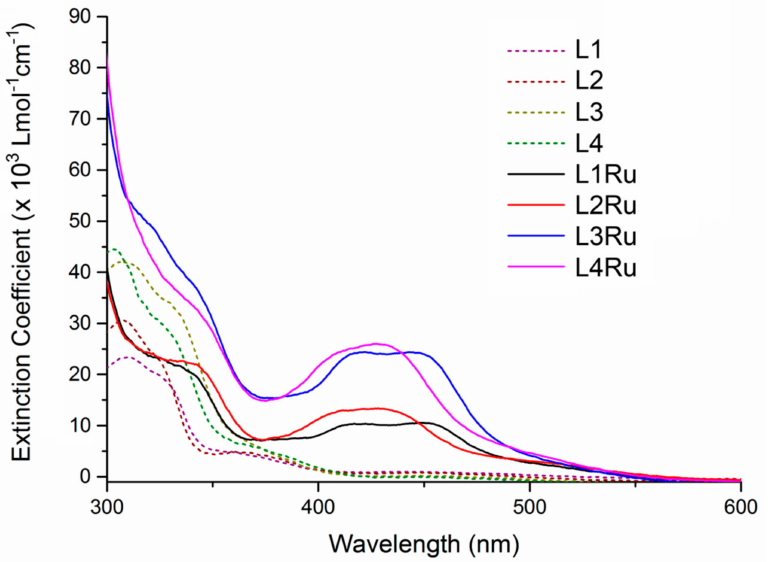
Figure 6. Overlaid UV-Visible spectra of L1–L4 and L1Ru − L4Ru recorded in dichloromethane solution (~10 − 5 molL − 1 , 298